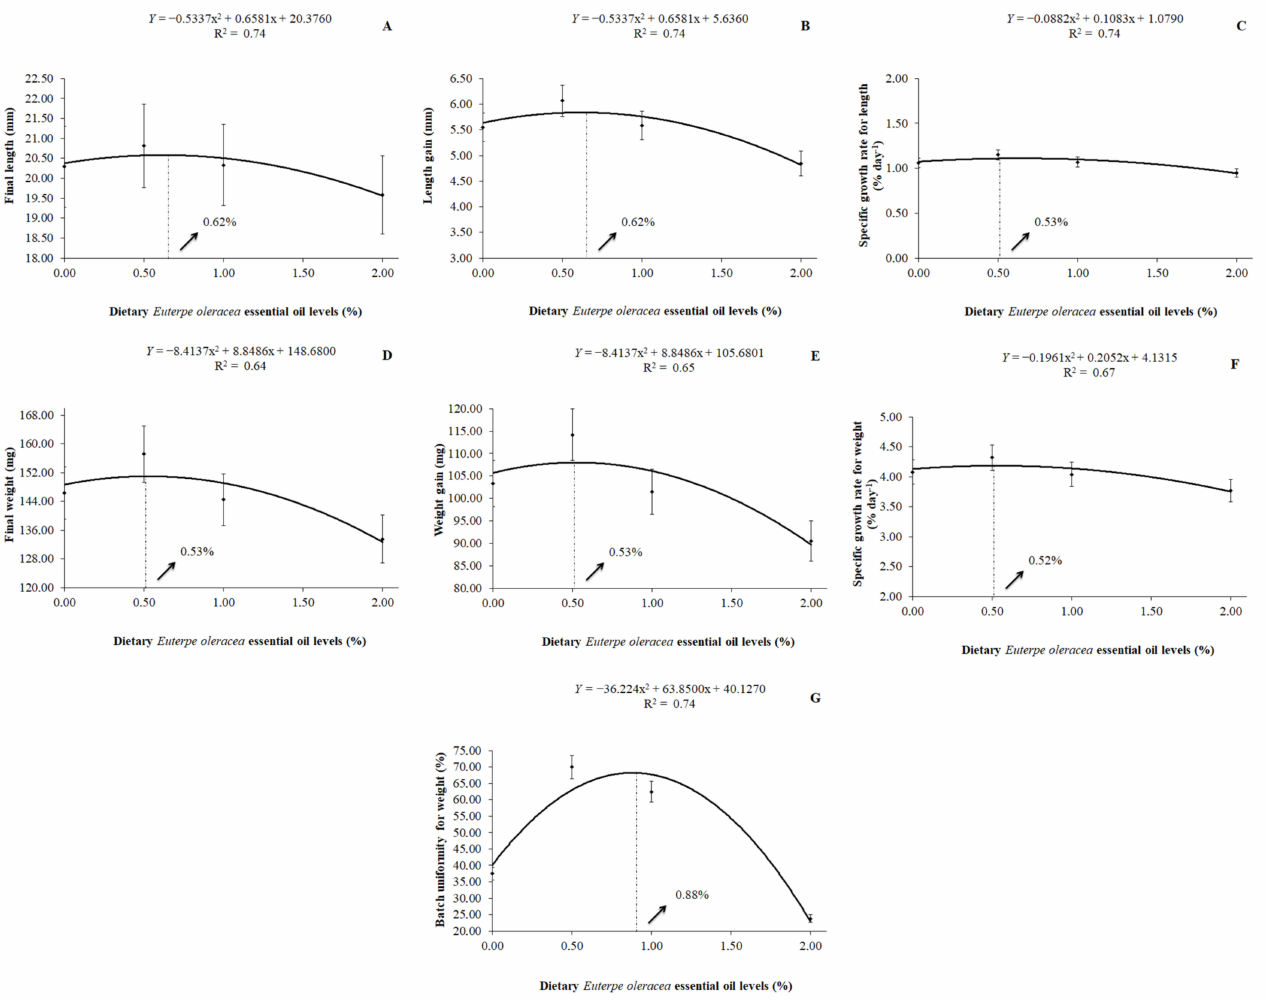
Figure 2. Final length ( A ), length gain ( B ), specific growth rate for length ( C ), final weight ( D ), weight gain ( E ), specific growth rate for weight ( F ), and batch uniformity for weight ( G ) of H. severus post-larvae fed diets containing levels of dietary Euterpe oleracea essential